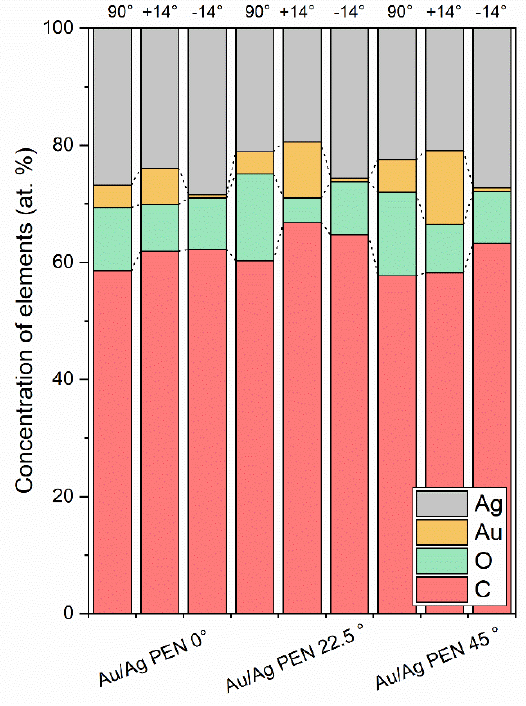
Figure 4. The concentrations of Au, Ag, C and O on Au/Ag PEN 0/22.5/45° samples determined by AR-XPS.